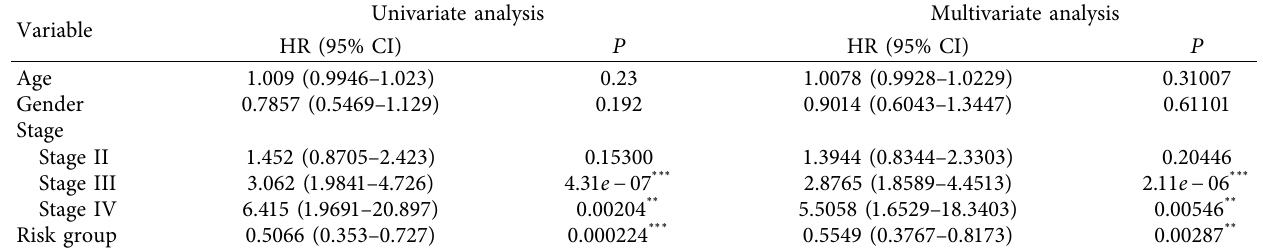
Table 4: Univariate and multivariate Cox regression analyses on the survival of HCC patients.